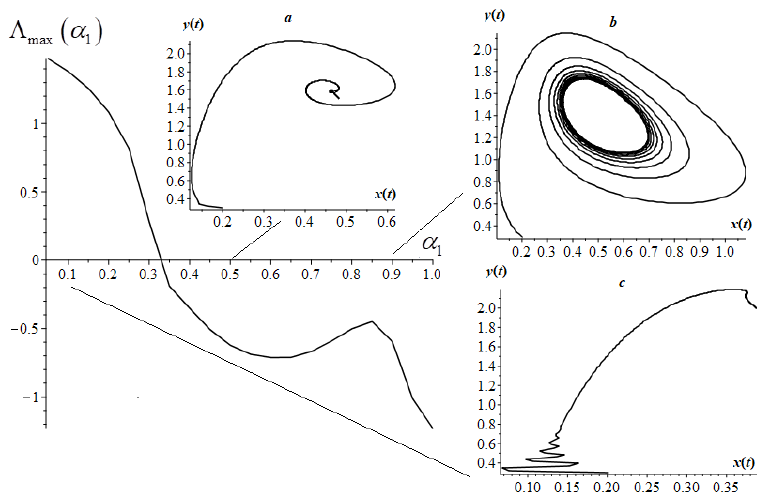
Figure 1. Spectrum of maximum Lyapunov exponents Λ max ( α 1